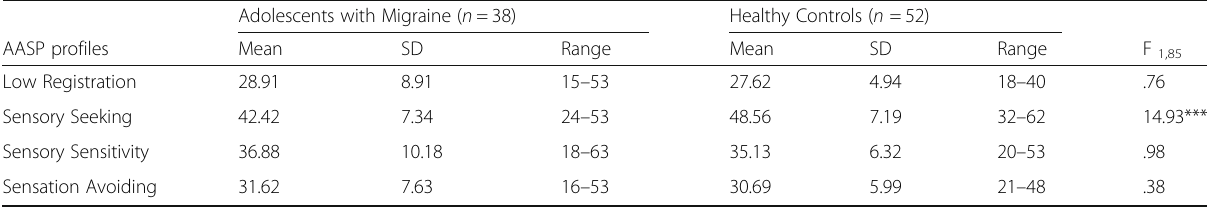
Table 3 Comparing the sensory processing patterns (according to the AASP) between adolescents with Migraine and healthy